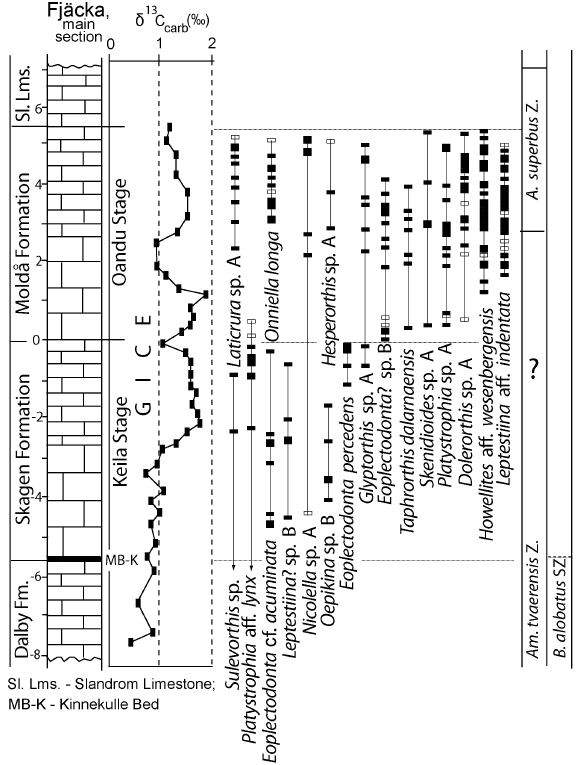
Fig. 5. Carbon isotopes, distribution of brachiopods and conodont biozones and subzones in the Fjäcka section, Sweden after Bergström et al. (2010, 2011) and Jaanusson (1982). MB-K, Kinnekulle